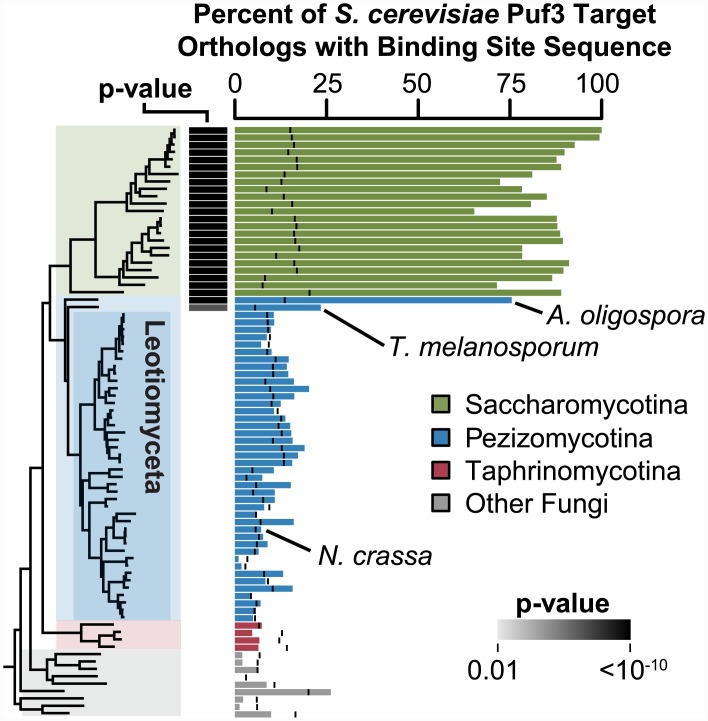
Conservation of S. cerevisiae Puf3 targets in other fungi.The percent of orthologs of S. cerevisiae Puf3 targets (identified by Gerber et al. [25]) that have a match to the Puf3 motif UGUA[ACU]AUA in the 3' UTRs in each species is shown as a bar plot. A black vertical bar marks the background frequency of the Puf3 motif for each species. The 3' UTR was defined as the 500 nucleotides downstream of the stop codon. Only orthologs of S. cerevisiae Puf3 targets that have a Puf3 motif match in 3' UTR were used (n = 176) so that S. cerevisiae S288C is set at 100%. A significant p-value (gray or black box) indicates that Puf3 motif matches are enriched in orthologs of S. cerevisiae Puf3 targets relative to all other orthologs. p-Values were computed using Fisher's exact test and are Bonferroni corrected for multiple hypothesis testing by multiplication by 80, the number of species tested. The phylogeny represents the evolutionary relationships of the fungi, inferred with a maximum-likelihood approach from a concatenated alignment of 20 protein sequences (Materials and Methods). Species names can be found in S19 Fig Percentages and p-values can be found in S1 Dataset.